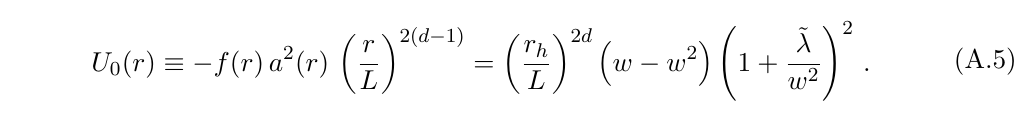
Figure 7 . Left: The effective potentials U 0 with − 1 < with ˜ λ < − 1 or ˜ λ > ˜ λ . The late-time linear growth of C crt1 the local maximum located inside the black hole interior (e.g., taking − 1 < ˜ λ < ˜ λ b ( r ) = 0 . As defined in eq. (2.19), the corresponding effective potential without the